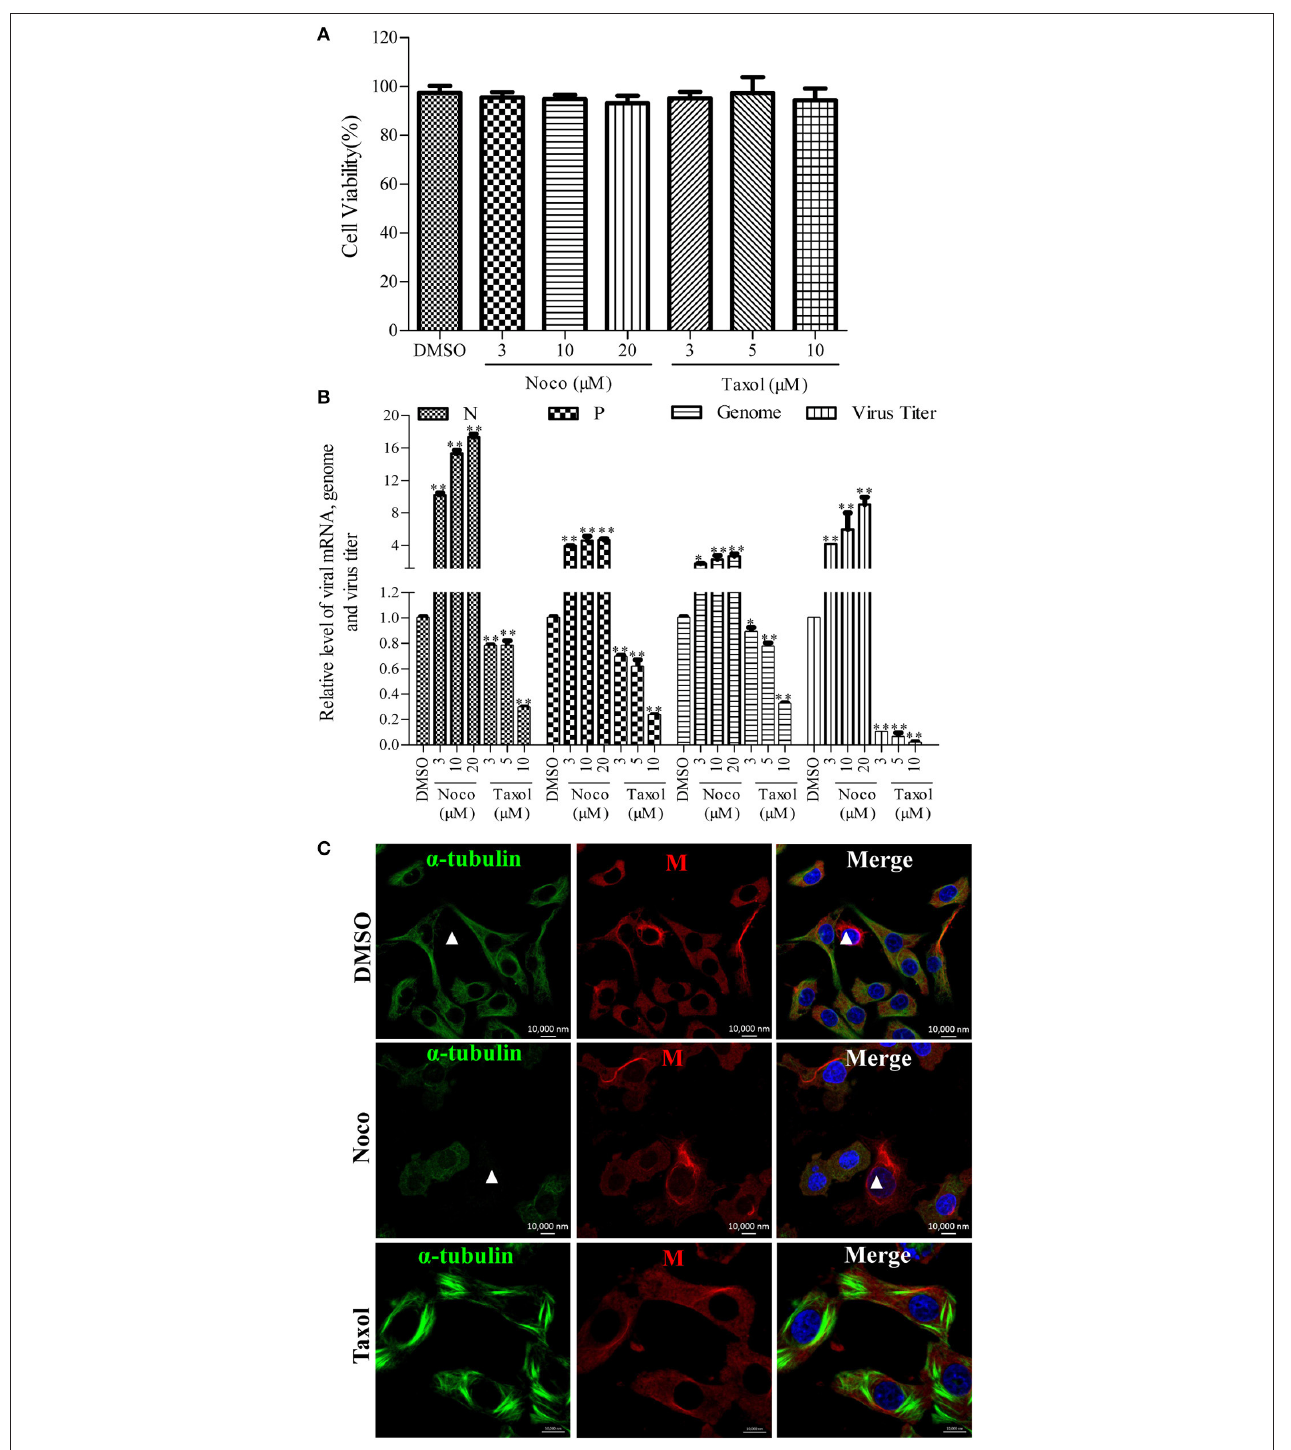
FIGURE 2 | Effects of Noco or Taxol treatment on viral RNA synthesis. (A) Detection of the cellular viability of N2a cells incubated with Noco, Taxol, or DMSO (as control) for 20h by CCK-8. (B) The quantitative analysis of viral N and P mRNA, viral genomic RNA, and viral titer. The N2a cells were infected with RABV for 4 h and then incubated with Noco, Taxol, or DMSO for another 20 h. The cells were collected for viral RNA extraction. Quantitative real-time PCR was performed to detect the viral genes and genome. The titers of infectious RABV progeny from culture supernatants were determined by TCID 50 . (C) The distribution of the viral M protein (red) and microtubule cytoskeleton (green) in RABV-infected N2a cells in the presence of Noco, Taxol, or DMSO at 24 hpi. Nuclei (Nuc) were stained with DAPI (blue). The white triangles indicate the cells which have a filamentous network viral M protein and disrupted microtubules. Scale bars, 10,000 nm. Data are represented as the means ± SD ( n = 3; *represents P < 0.05, **represents P < 0.01).